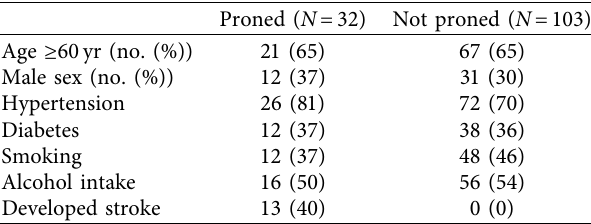
Table 1: Baseline characteristics of patients. Table 2: Clinical predictors of stroke.